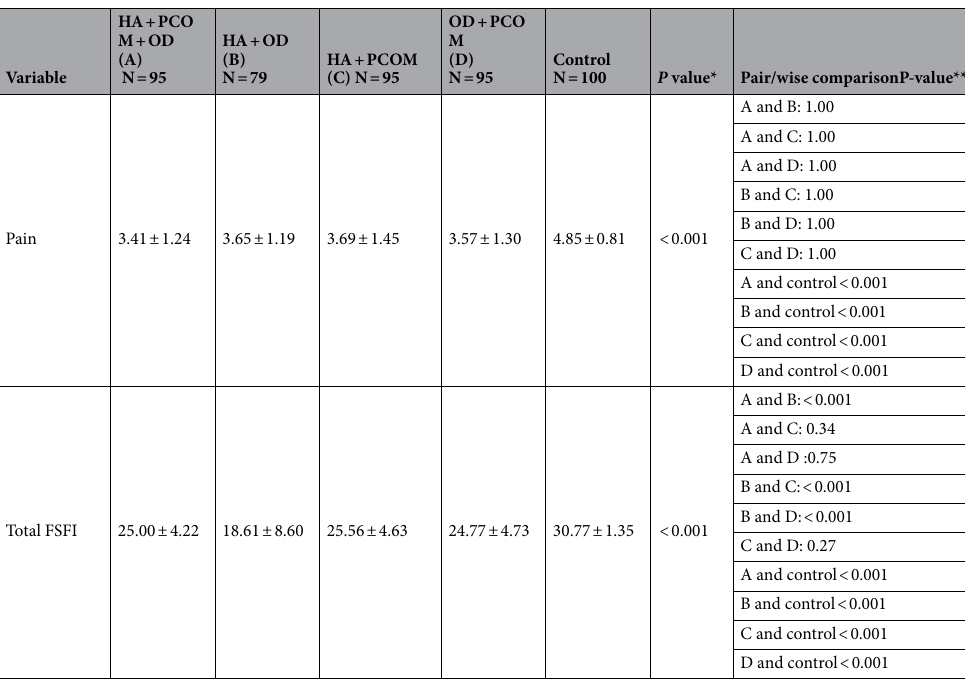
Table 3. Comparison of FSFI and its domains between different phenotypes of PCOS. PCOS Polycystic Ovary Syndrome, PCOM Polycystic Ovaries Morphology, OD Ovulatory Dysfunction, HA